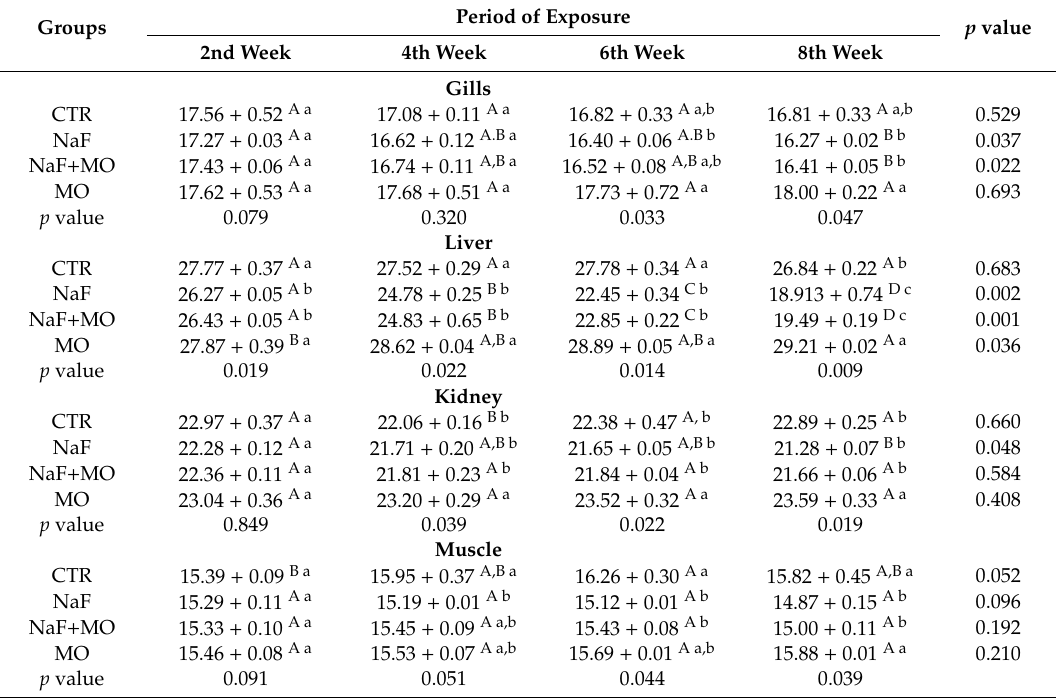
Table 6. E ff ect of sodium fluoride (NaF) and / or M. Oleifera (MO) on glutathione peroxidase (GPx) (U / g tissue) in tissue homogenates of O. niloticus gills, liver, kidney, and muscle.